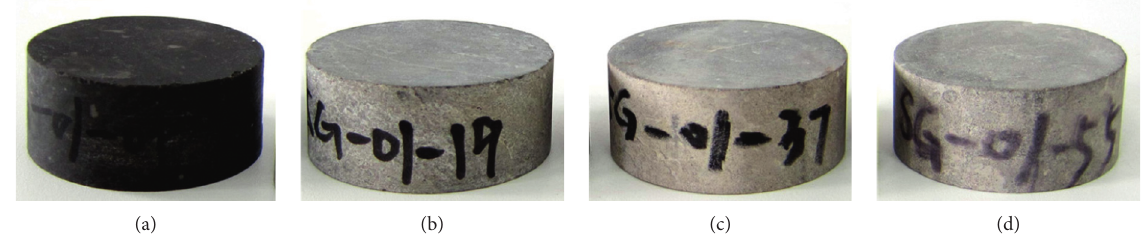
Figure 2: Apparent morphology of limestone specimens after high temperature. (a) 25 ° C. (b) 200 ° C. (c) 400 ° C. (d) 600 ° C.